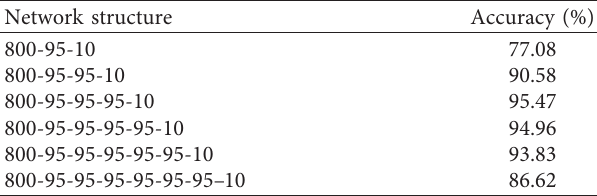
Table 1: Comparison of the results of different hidden layers. Network structure